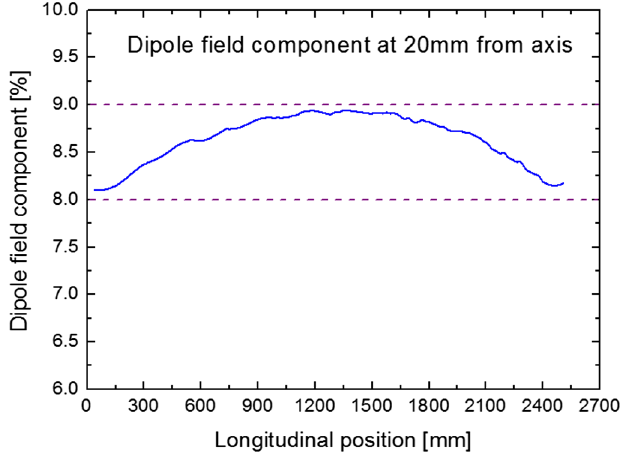
FIG. 11. The dipole field component at a transverse position of 20 mm according to the simulation.